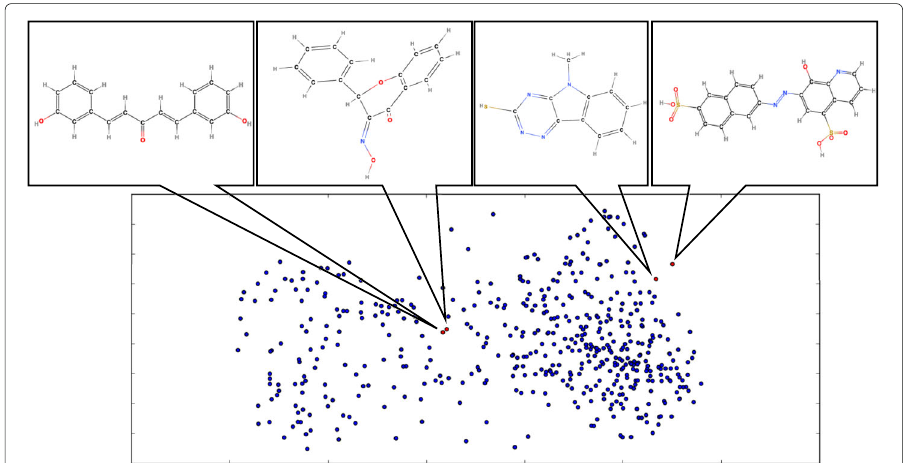
Fig. 7 The embeddings for graphs in the HIV dataset visualized in 2D space (we used Kernel PCA (Mika et al. 1998) for dimension reduction). We highlight two different pairs of embeddings that are close to each